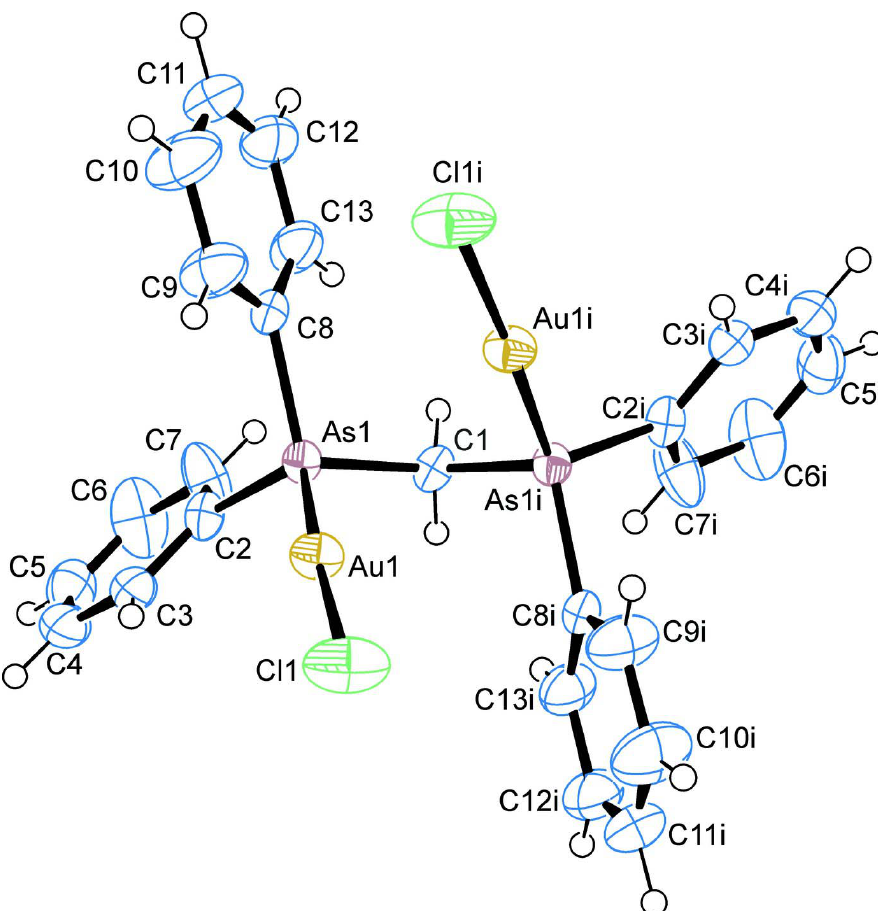
Figure 1 View of the title compound with the atom numbering scheme (symmetry code: (i) - x , y , - z + 1/2). Displacement ellipsoids for non-H atoms are drawn at the 50% probability